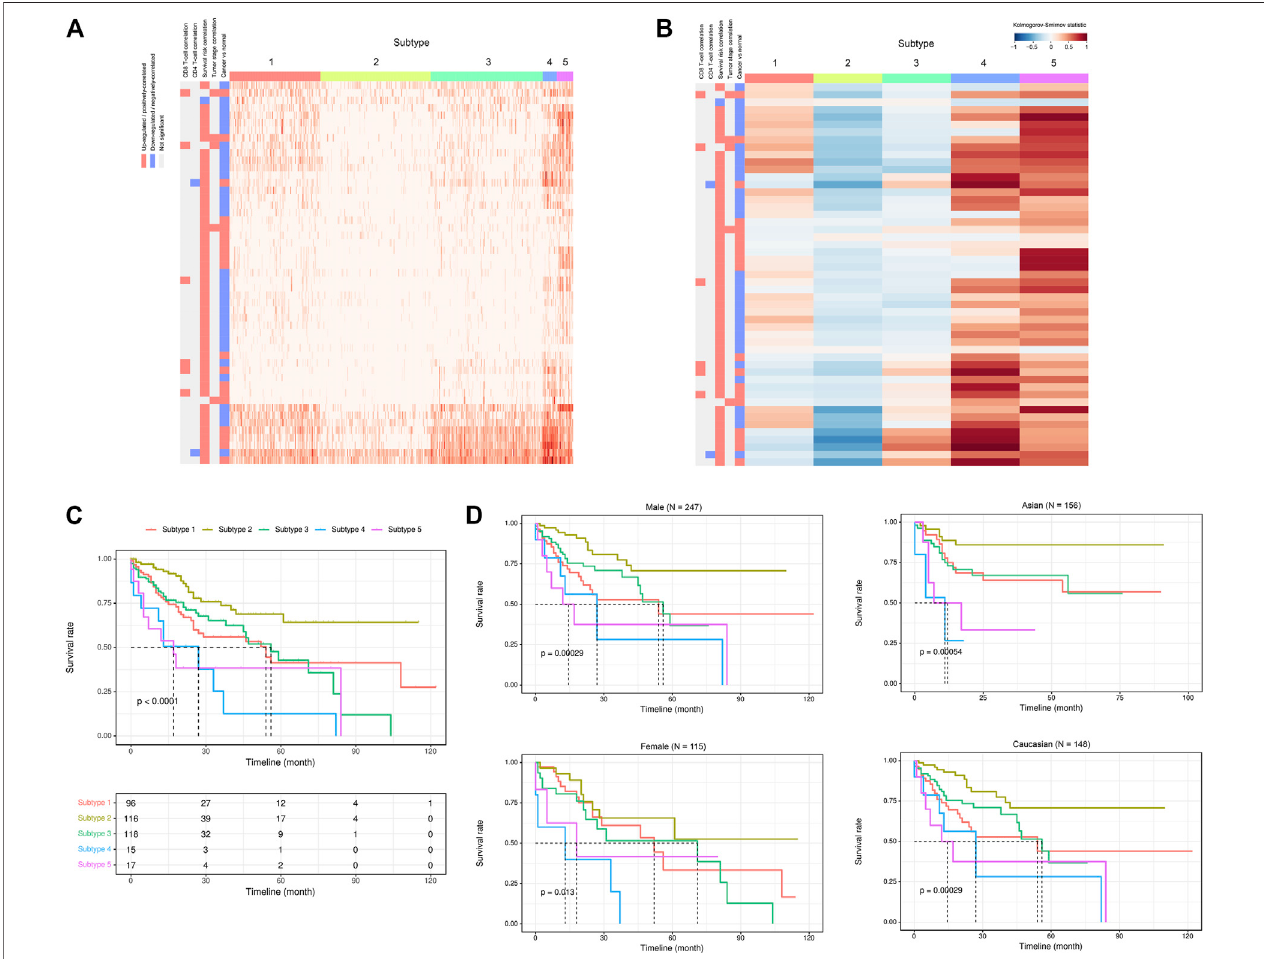
FIGURE8| ca-tRF-basedsubtypesandcorresponding survivaldistinctioninLIHC. (A) Thesubtypessuggestedbyca-tRFexpressionpattern.Columnsandrows represent samples and ca-tRFs, respectively, and the color blocks along columns and rows represent subtypes and various ca-tRF-related biological features, respectively. (B) Heatmap of Kolmogorov-Smirnov statistics showing relative ca-tRF expression abundance across subtypes. (C) Kaplan-Meier plots showing the distinction of survival among different subtypes. The risk table showing the sample number at risk is also shown below for reference. (D) Sex- and race-speci fi c Kaplan-Meier plots showing the distinction of survival among different